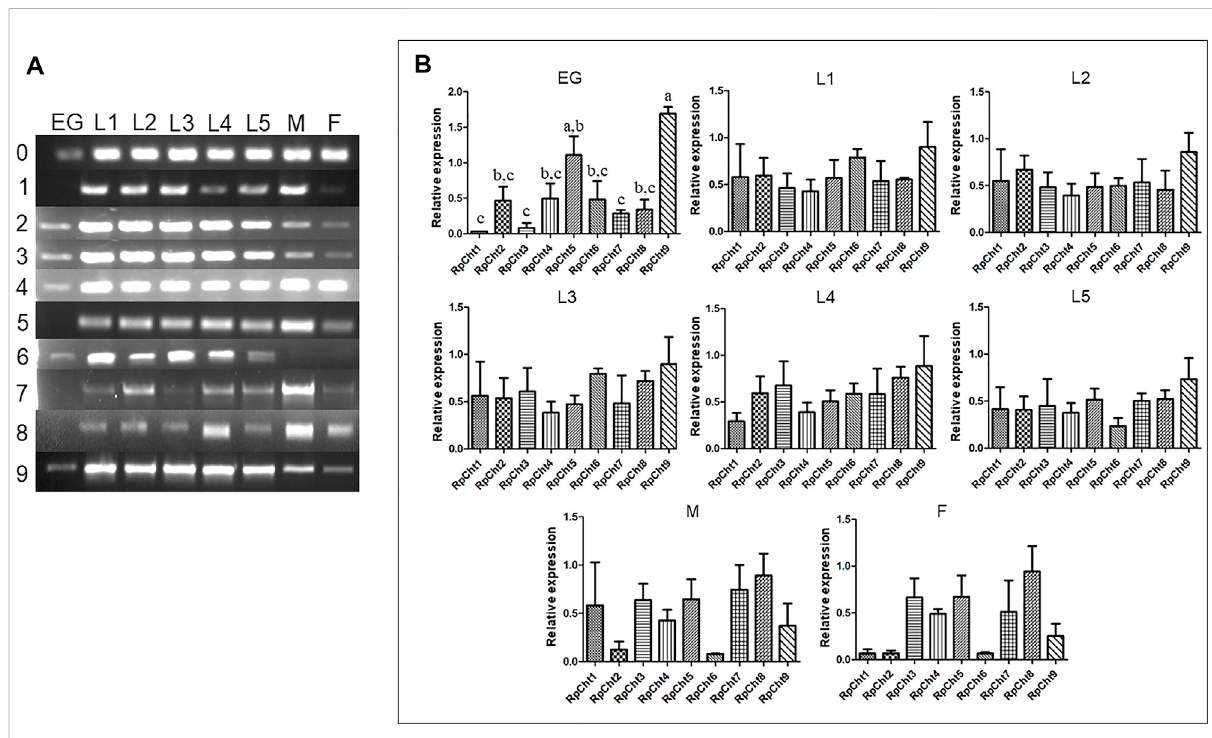
FIGURE 4 Expression pro fi ling of chitinase genes in different developmental stages of R. prolixus as evaluated by RT-PCR. (A) Columns correspond to the result fromentireinsects, includingnymphs( fi rstto fi fth instars: L1 – L5),male(M)and female(F)adults,andeggs (EG).Lane0istheconstitutiveactin, and 1 – 9 represent genes RpCht1-9 , respectively. (B) Relative expression with the Actin expression used as a constitutive reference gene, obtained withtheImageJprogram(bybanddensitometry).Valuesmarkedwitha,bandccorrespondtosigni fi cantly differentgroups( p < 0.05;one-way ANOVA – Tukey). The experiment was performed three times with independent biological